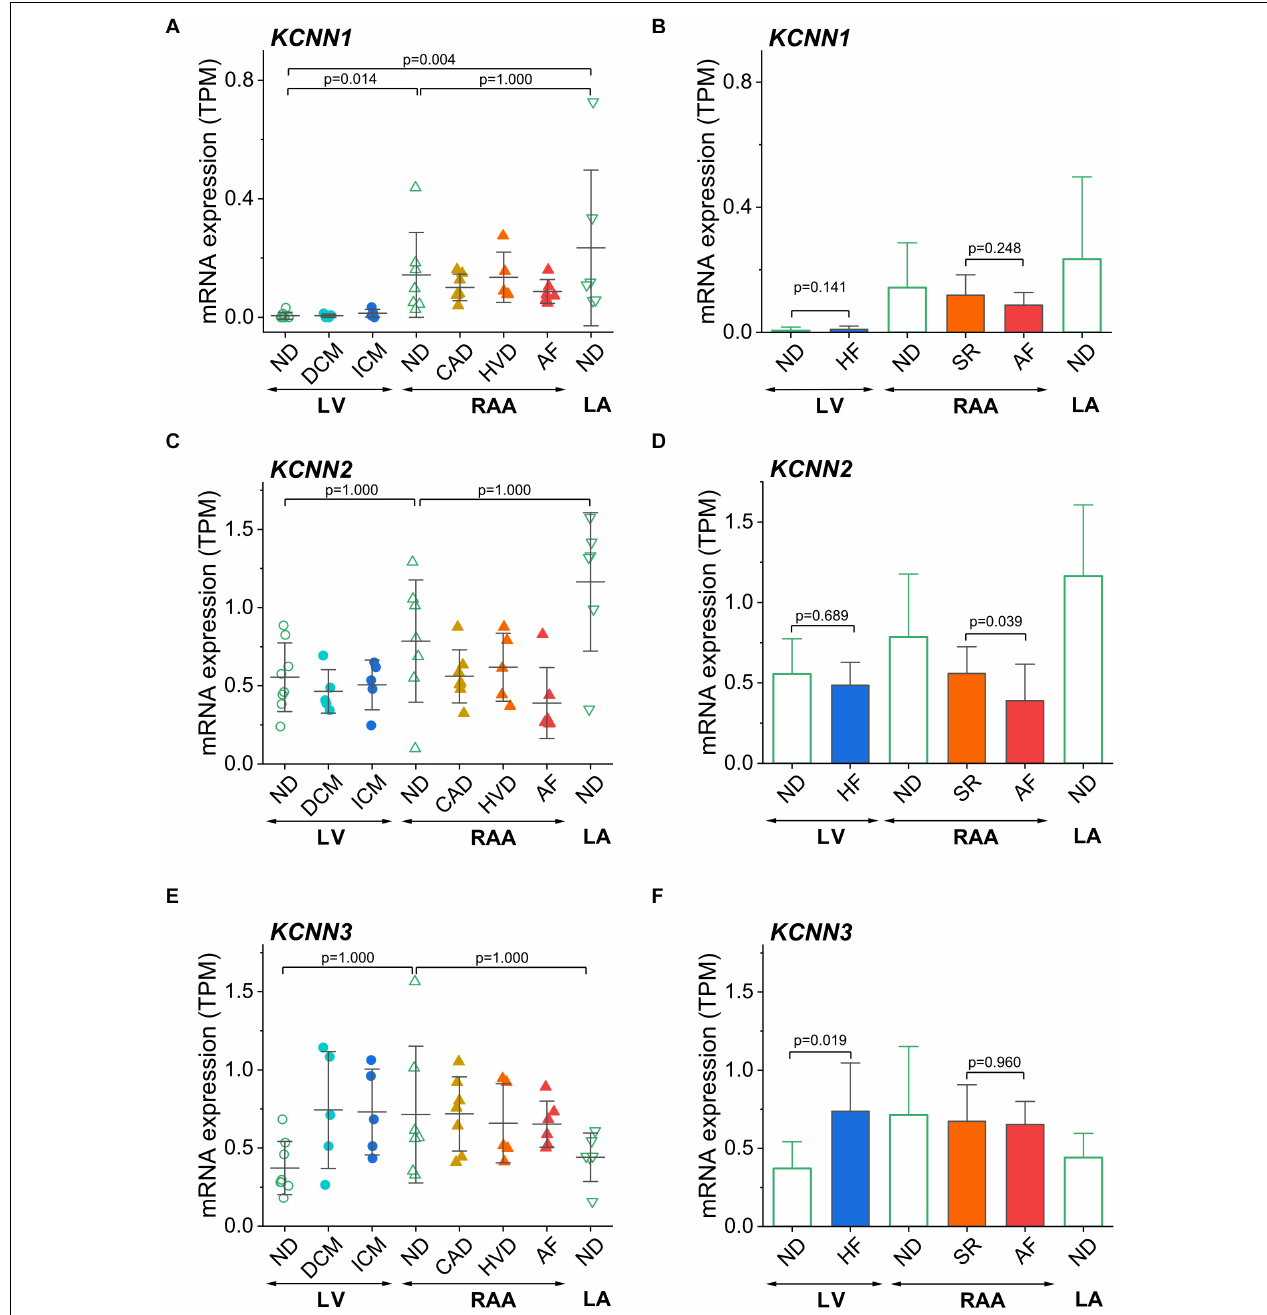
FIGURE 6 | Assessment of chamber-selective and disease-related mRNA expression of SK channels in transcripts per kilobase million (TPM) assessed by RNA-seq. (A) Expression of KCNN1 (SK1) in all sample groups; (B) Comparison of KCNN1 expression in LV tissue from non-diseased and failing hearts, in right atrial tissue from SR and AF patients, and in non-diseased left atrial tissue from non-diseased hearts. (C,D) Expression of KCNN2 (SK2); (E,F) expression of KCNN3 (SK3), figure lay-out as in (A,B) . Sample provenance, patient’s health status and statistical tests as in Figure 3 . Since disease-associated differences in expression of SK channels were our main concern, we separately depicted the statistical comparisons for HF and AF (B,D,F)